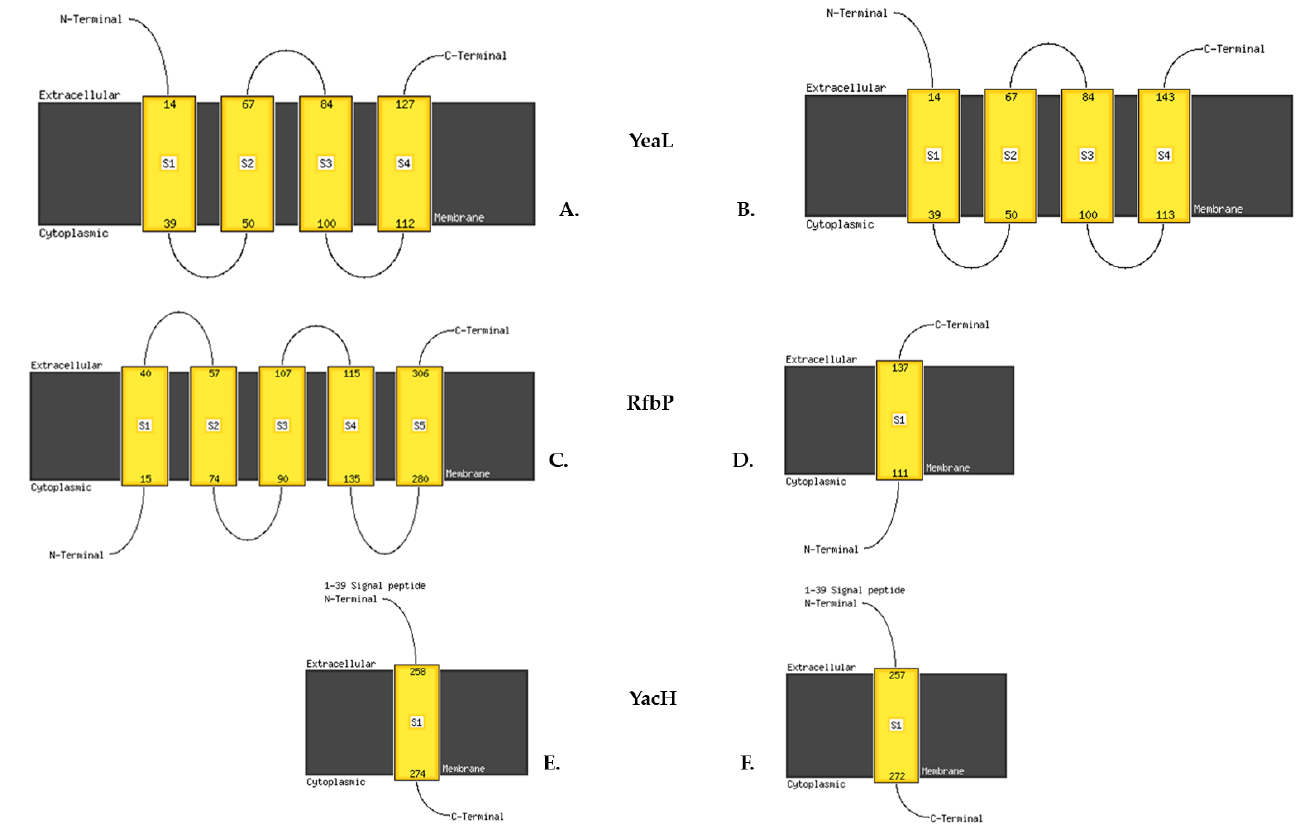
Figure 5. Predicted transmembrane helices. Functional ( Salmonella enterica subsp. Enterica Typhimurium LT2, left panel) and truncated ( Salmonella enterica subsp. Enterica Typhimurium 4:i:1,2_69M, right panel) proteins. YeaL UPF0756 membrane protein ( A ). YeaL LT2 (148 aa), ( B ). YeaL 69M (134 aa); RfbP O-antigen transfer protein ( C ). RfbP LT2 (476 aa), ( D ). RfbP 69M (307 aa); YacH membrane protein ( E ). YacH LT2 (540 aa), ( F ). YacH 69M (285 aa). Created by Phyre2, Protein Homology/analogY Recognition Engine V 2.0, London, UK. Insertion 390_391insC, Val130_Arg131fs, creates a new STOP codon in the yeaL gene, re-